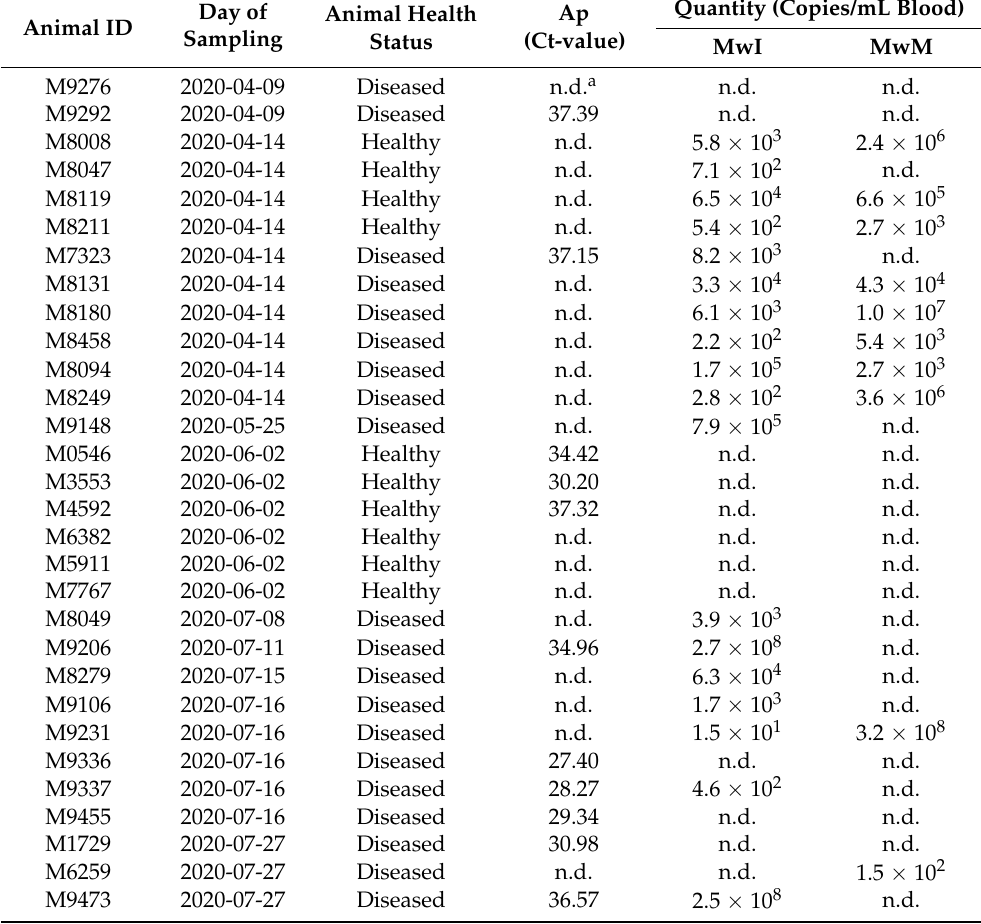
Table 1. Detection of Anaplasma phagocytophilum (Ap), Mycoplasma wenyonii str INIFAP02-like (MwI) and M. wenyonii str Massachusetts-like (MwM) with real-time PCR in blood samples taken